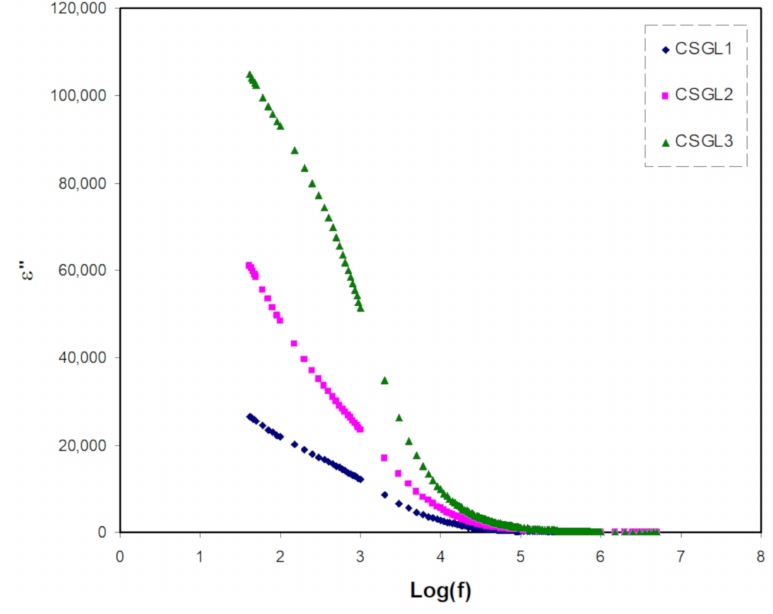
Figure 3. Dielectric loss versus log (f) for all polymer blend